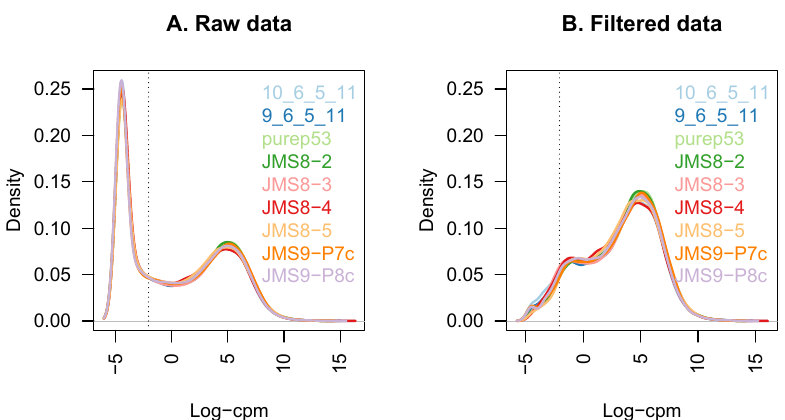
Figure 1. The density of log-CPM values for raw pre-filtered data ( A ) and post-filtered data ( B ) are shown for each sample. Dotted vertical lines mark the log-CPM threshold (equivalent to a CPM value of about 0.2) used in the filtering